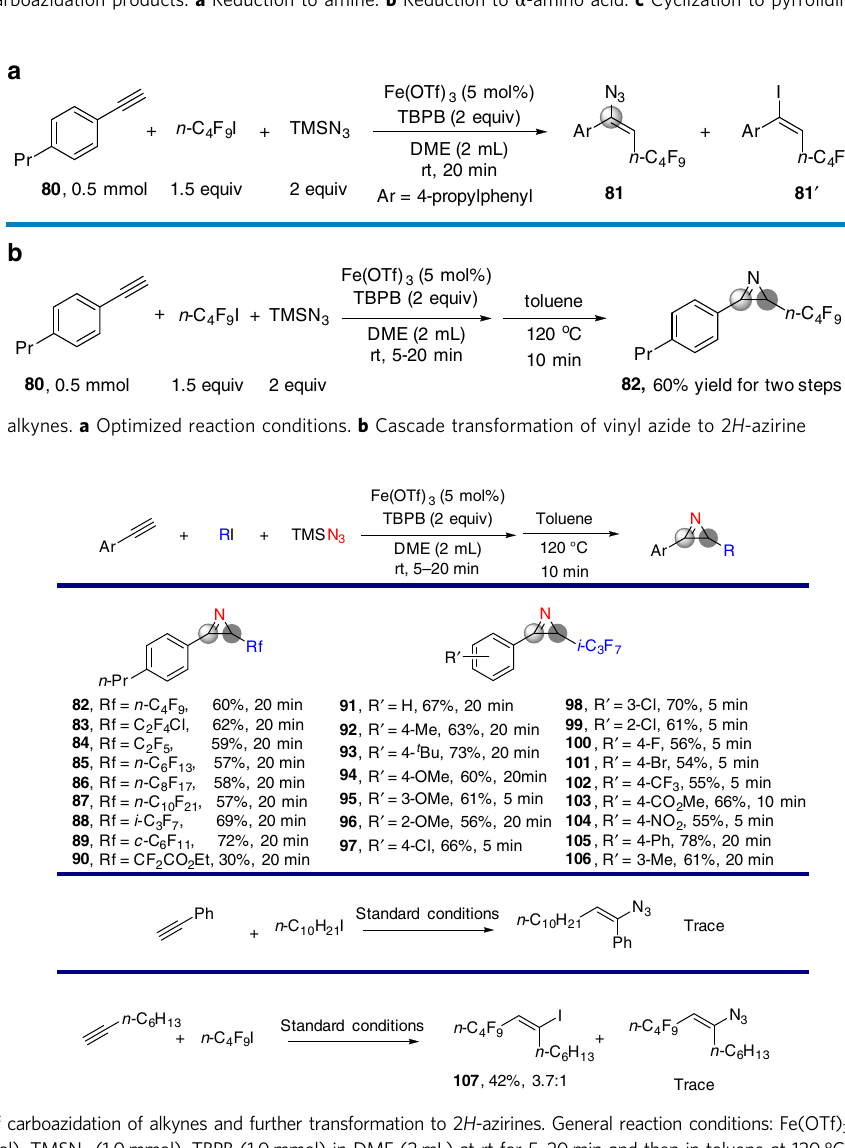
Fig. 5 Applications of carboazidation products. a Reduction to amine. b Reduction to α -amino acid. c Cyclization to pyrrolidinones